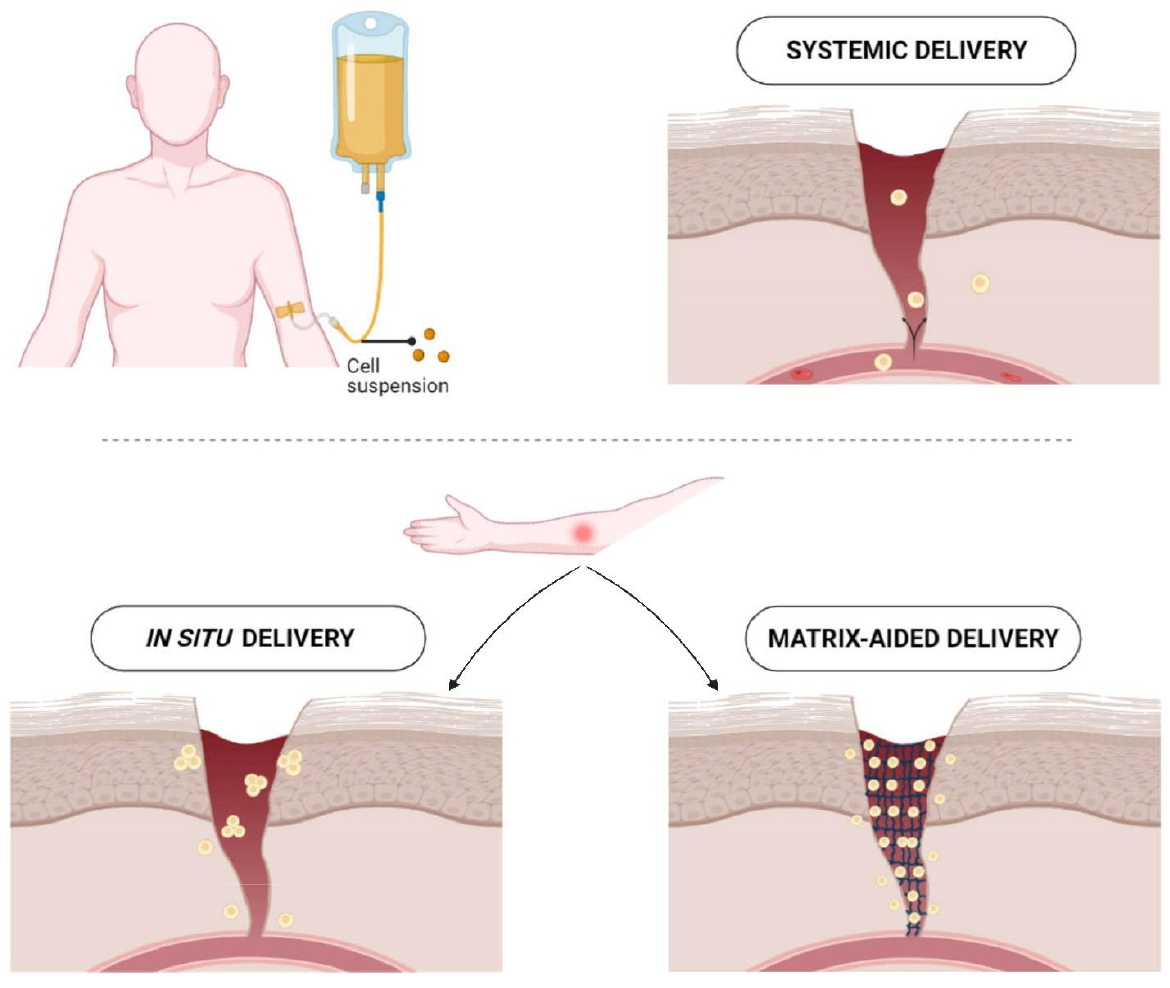
Figure 1. Different routes of cell delivery to cutaneous wound. In clinical interventions, cell therapy is conducted using systemic delivery, which has off-target effects. Although it affords localization of cells, in situ delivery fails to maintain therapeutic doses. Matrix-aided delivery of cells is considered a promising breakthrough for overcoming the existing challenges and providing more opportunities.